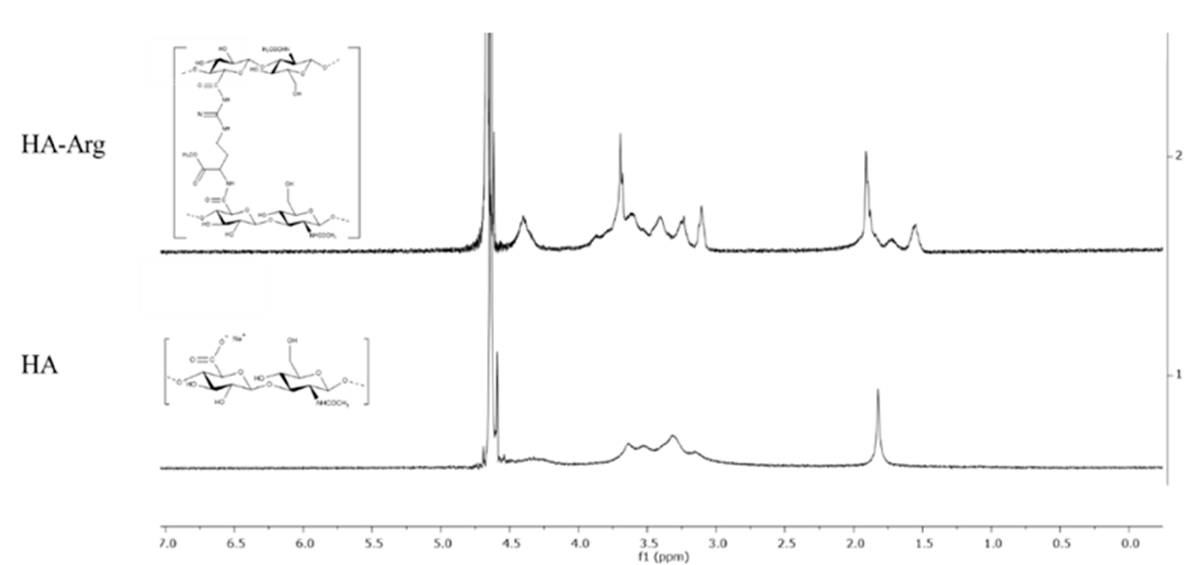
Figure 2. 1 H-NMR profile of cross-linked HA–Arg and native HA.